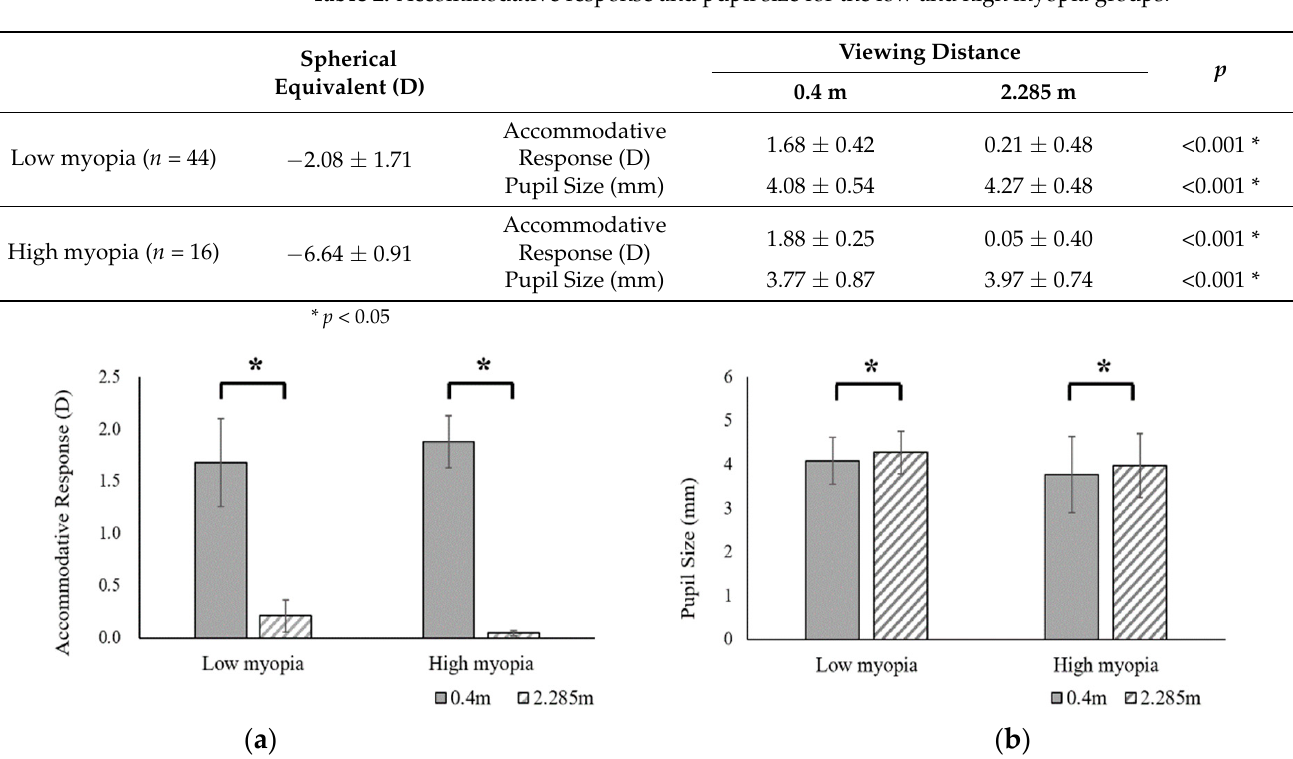
Table 2. Accommodative response and pupil size for the low and high myopia groups.